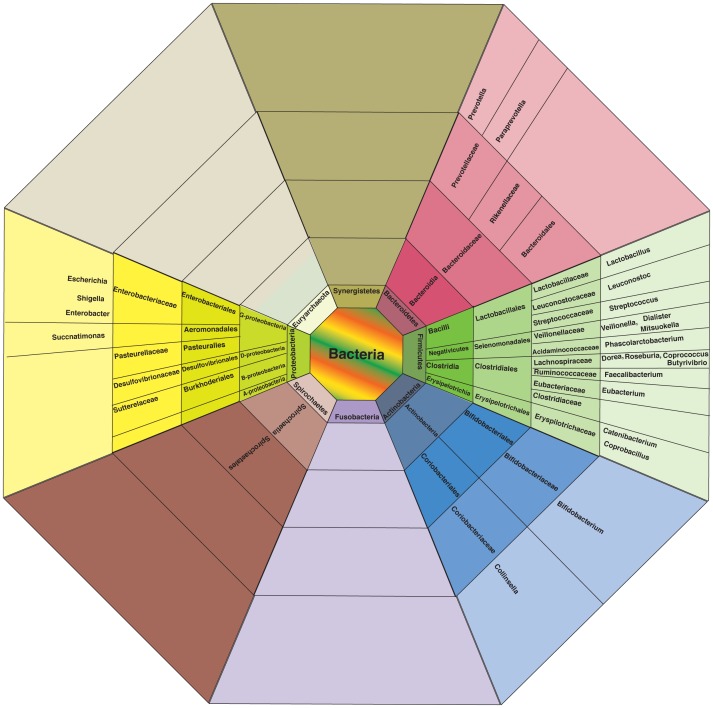
Distribution of taxonomic groups at various levels (including the core set of 23 genera) commonly present across at least 50% metagenomes with normalized abundance ratios of more than 0.01.